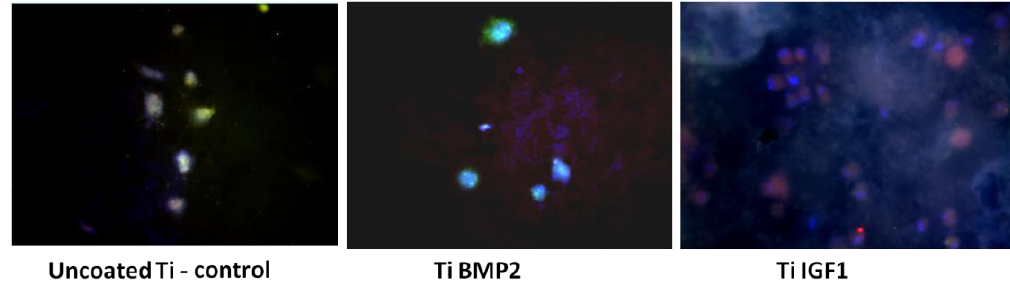
Figure 13. Immunocytochemical staining of BM MSC cells cultivated onto titanium implants for 21 days, with Texas red (red) for osteopontin OP and FITC (green) for osteocalcin OC.